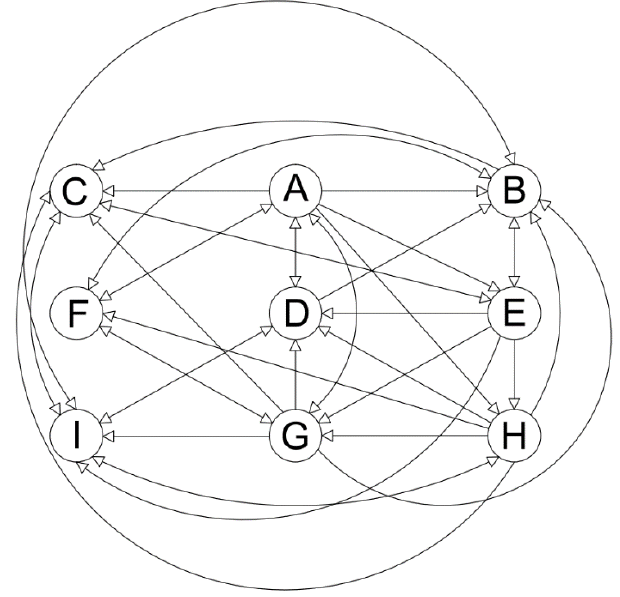
Figure 5. Interrelationships among nine barriers to climate change adaptation in Tehran.